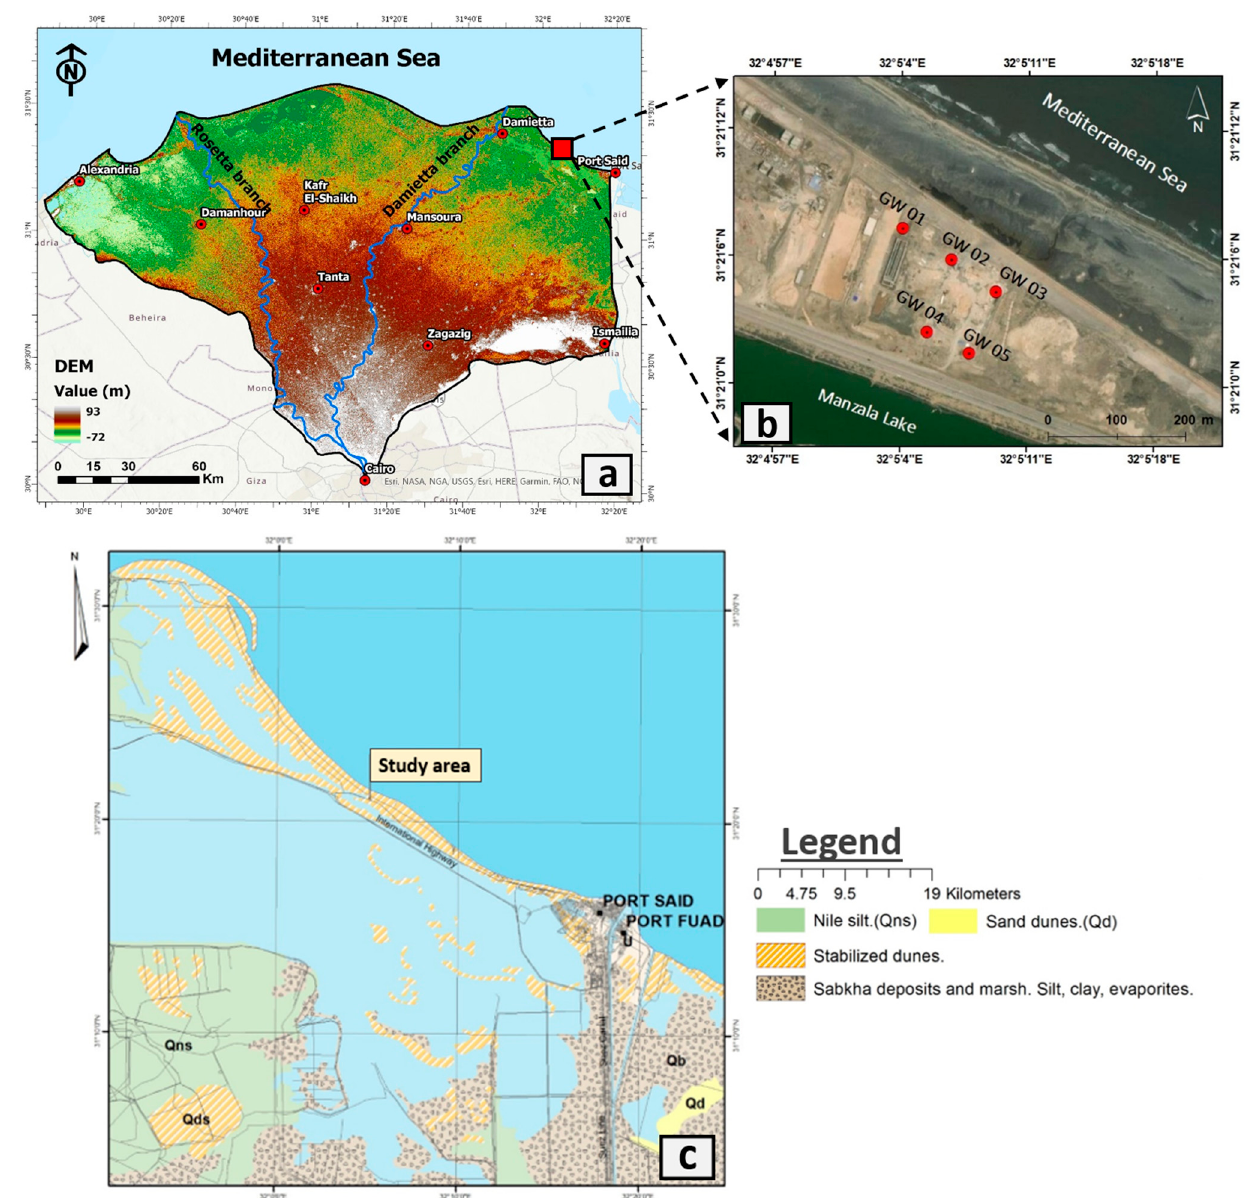
Figure 1. ( a ) The topography of Nile Delta, Egypt. ( b ) The study area with five test wells. ( c ) Geo- morphologic units along the study area [41].